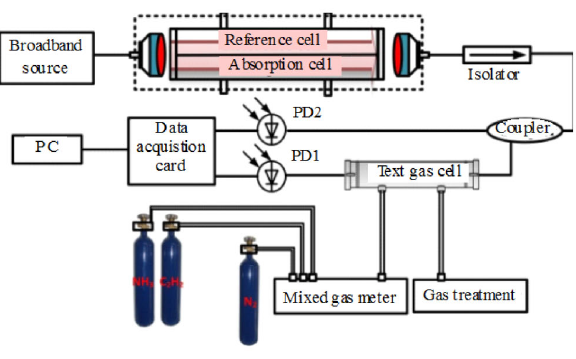
Fig. 8 Schematic of multiple gases detection